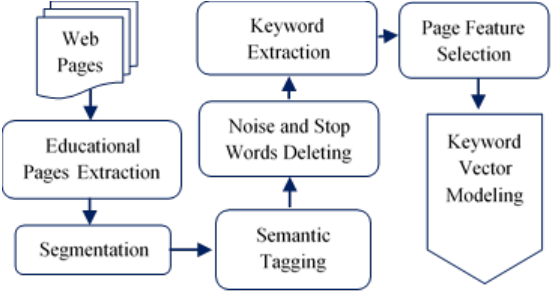
Figure 2. Educational Resource Extraction Process.